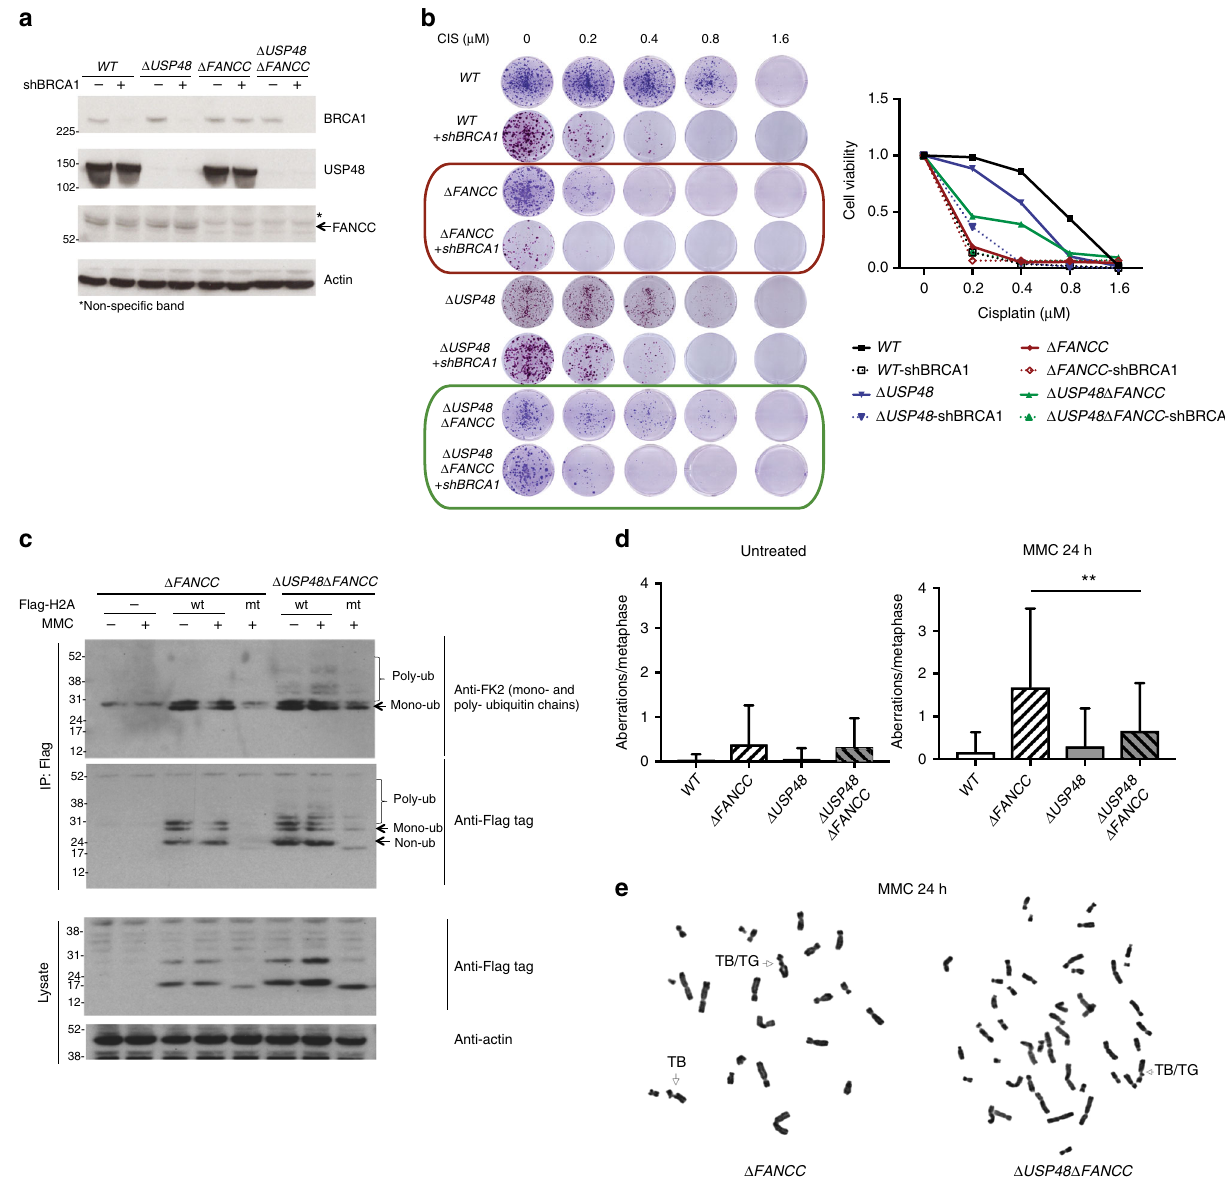
Fig. 6 USP48 acts on H2A and reduces chromosomal aberrations in FA cells. a Immunoblot for BRCA1, USP48, FANCC, and actin on the indicated cell lines. Asterisk (*) denotes non-speci fi c band. b Colony formation and quanti fi cation of cell survival of the indicated cell lines 7 days after treatment with MMC at the indicated doses. c Anti-Flag-H2A immunoprecipitation probed against FK2, Flag and actin for the indicated cell lines. Lower bands correspond to monoubiquitylation modi fi cations and higher bands correspond to poly-ubiquitin chains. Cells were transfected with wt = wild-type and mt = mutant (K5-9-118-119-125-127-129R) H2A and then treated with MMC (50 nM) for 4 h. d – e Plot of mean number of chromosomal aberrations ( d ) and representative images from metaphase spreads ( e ) of wild-type (WT), Δ FANCC and Δ USP48 Δ FANCC cells after treatment with MMC (25 nM) for 24 h. TB/TG: chromatid break/chromatid gap. Error bars show SD. Statistical signi fi cance was determined using the Mann – Whitney test with p < 0.05 as a threshold. ** = p <